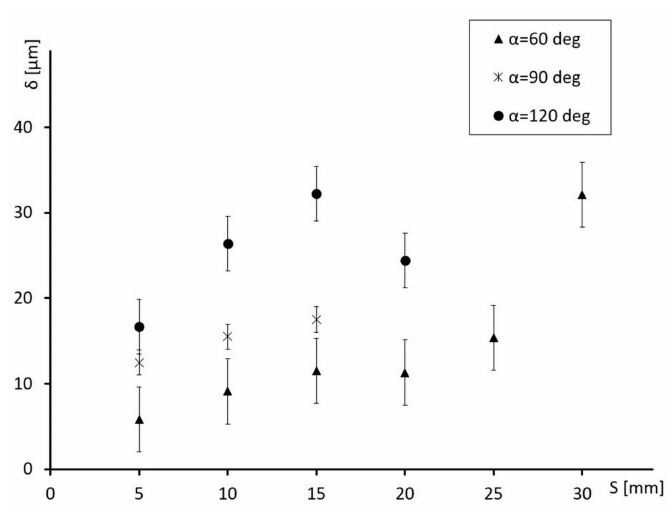
Figure 10. Variation of the thickness of the layer of severe plastic deformation with S and α